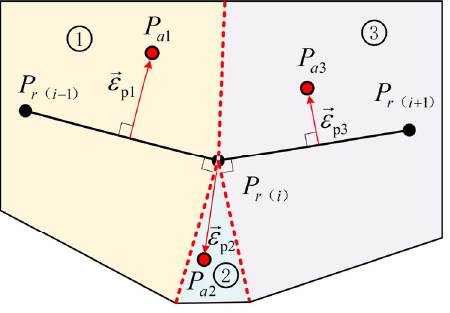
Figure 4. The calculation model of the TTPT contour error.